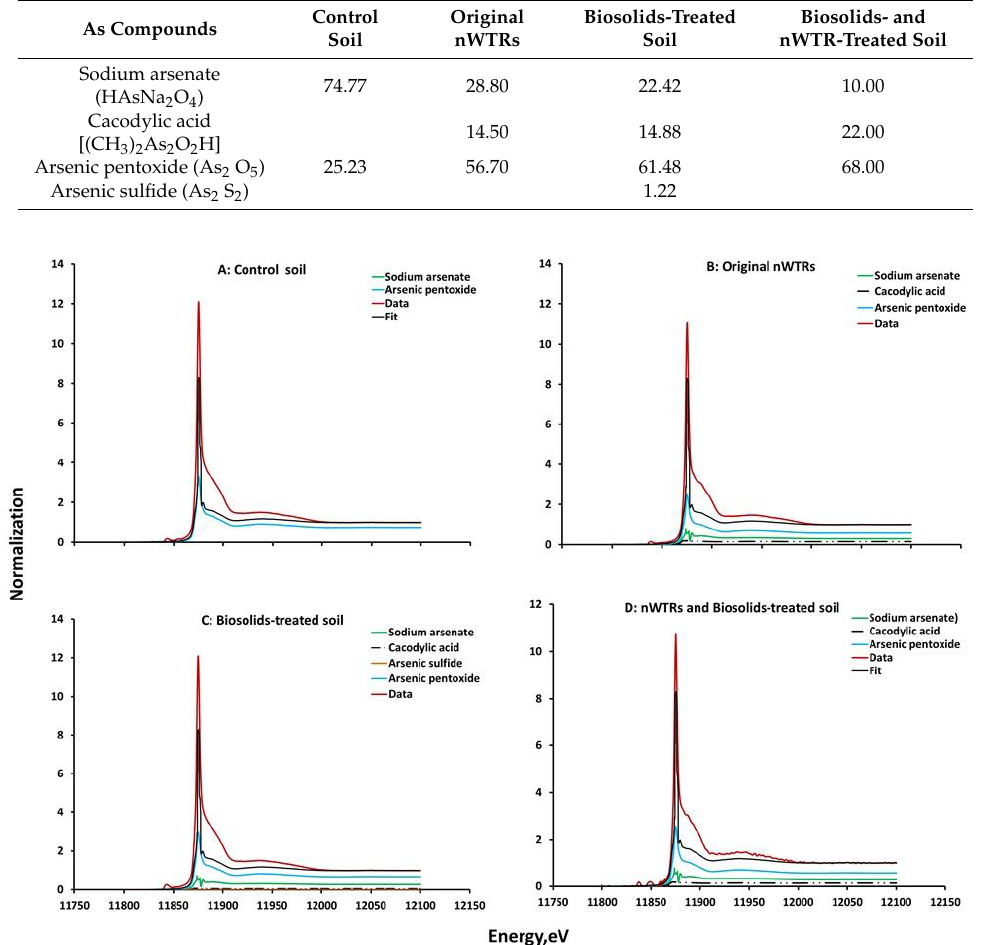
Figure 4. Spectra of arsenic (As) chemical components in the soil that was treated with biosolids (3%) and nanoscale drinking water treatment residuals (1% nWTRs), along with the As standards and the fit line. A: Control soil; B: Original nWTRs; C: Biosolids-treated soil; D: Biosolids- and nWTRs-treated